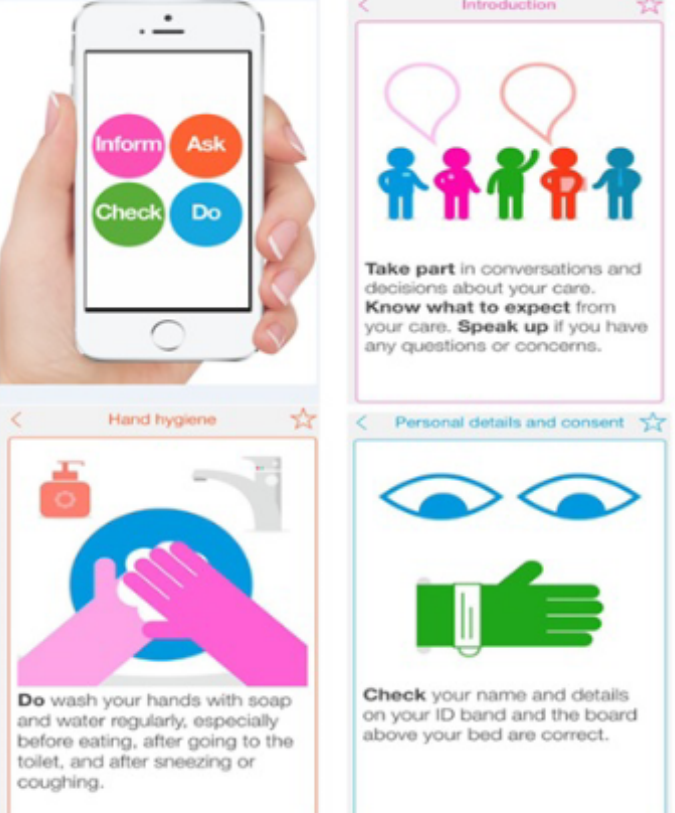
Figure 1. Screenshots from the MySurgery